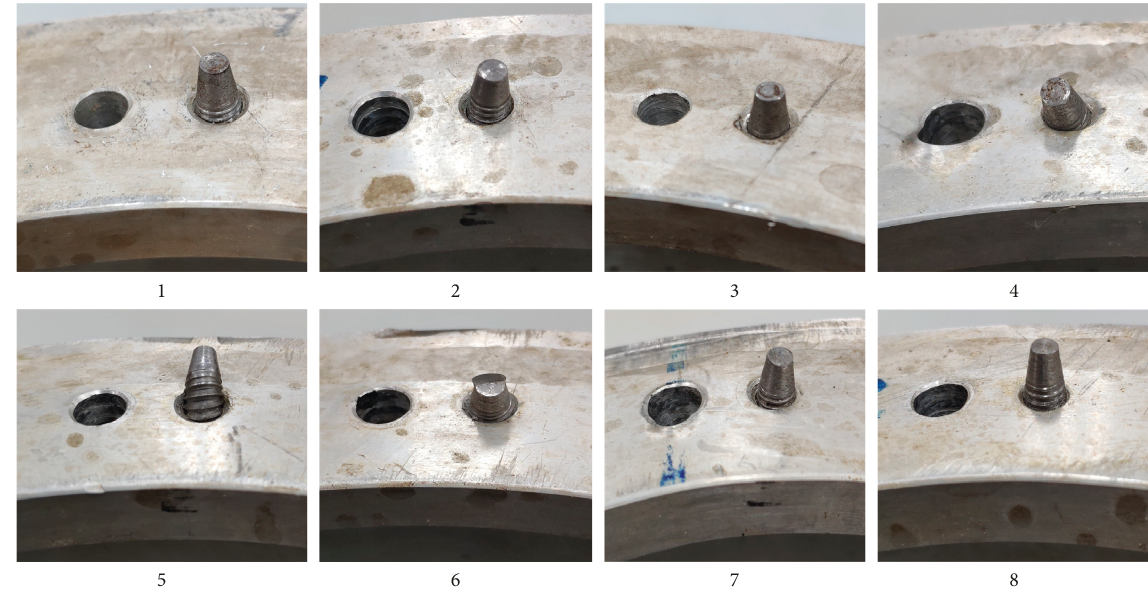
Figure 12: The experimental results of the shear pins.